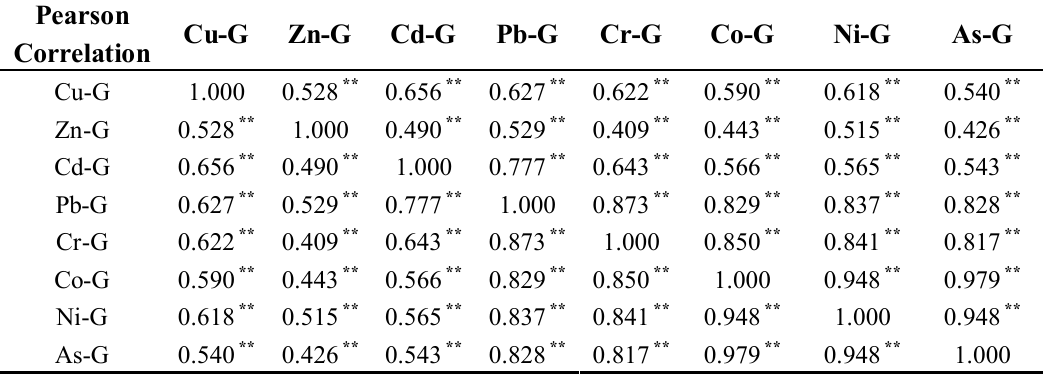
Table 9. Correlation Analysis of the metal(loid) Concentrations in